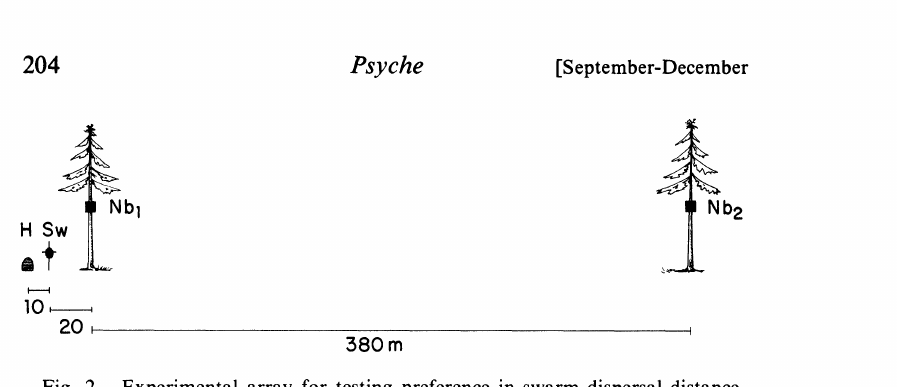
Fig. 2. Experimental array for testing preference in swarm dispersal distance. H, hive; Sw, swarm on wooden cross; Nb, nestbox. In the five trials of the test, the hive and swarm were alternately positioned near nestbox or nestbox 2, always maintaining the distance relationships shown. All distances are in meters. The ob- jects in this figure and the spacings between objects are not drawn to the same